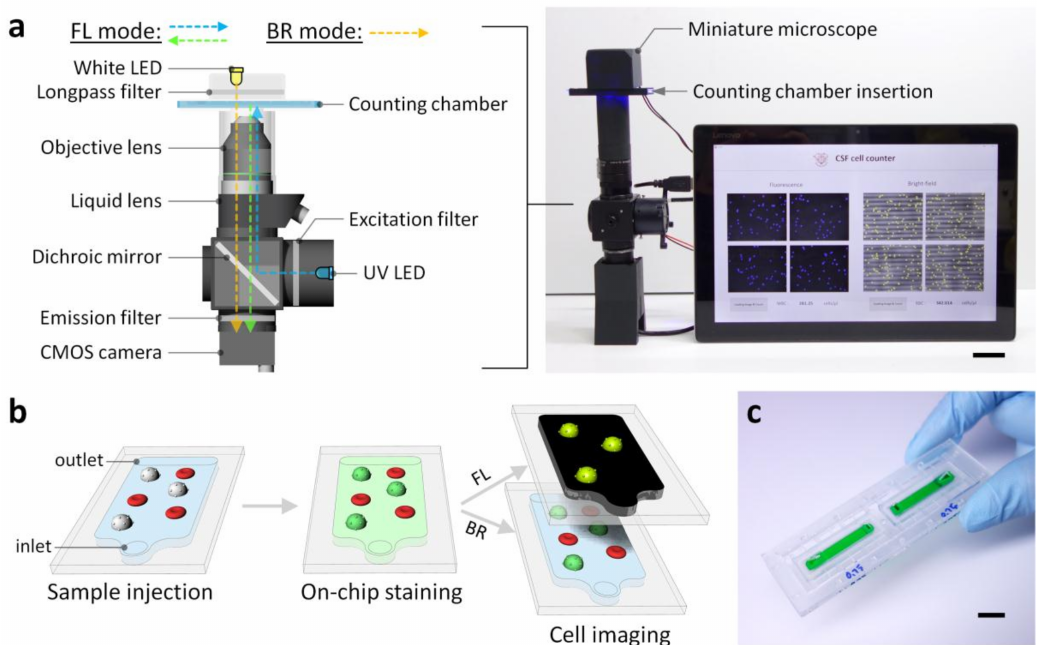
Figure 1. Portable platform for counting blood cells in CSF. ( a ) Schematic and photograph of the miniaturized bright-field and fluorescence microscopy which comprises a UV LED, an excitation filter (474 nm center wavelength), a dichroic mirror, a 20 × objective lens, a liquid lens, an emission filter (525 nm center wavelength), a white LED, and a long-pass filter (500 nm cut-on wavelength). Note that the schematic is not to scale and used to describe the internal optical components. The custom Matlab-based graphic user interface enables automatic RBC and WBC counting from bright-field (BR) and fluorescence (FL) images. Scale bar, 3 cm. ( b ) Illustrations of the cell counting chamber and on-chip fluorescence staining process. As a CSF sample is loaded, the cell permeable dye deposited on the chamber bottom dissolves and fluorescently stains nucleated cells. ( c ) Photograph of the cell counting chamber filled with food dye for visualization. Scale bar, 1